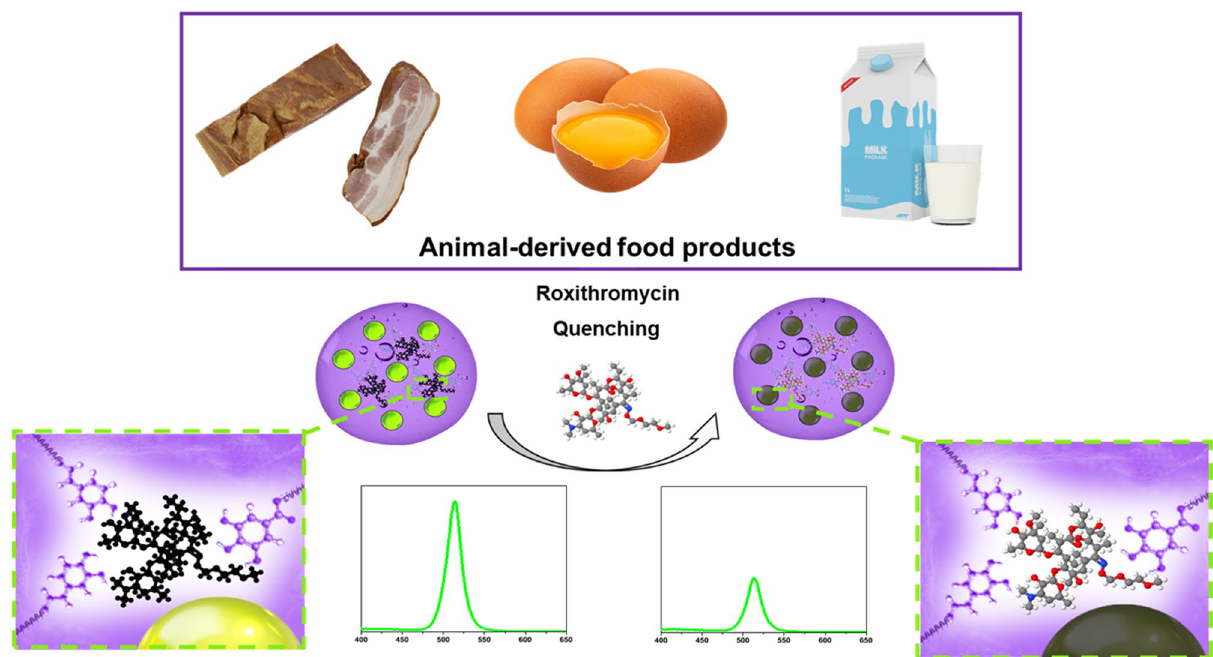
Figure 1. Schematic illustration of ROX sensing in animal-derived food using perovskite-loaded MIP nanogel.